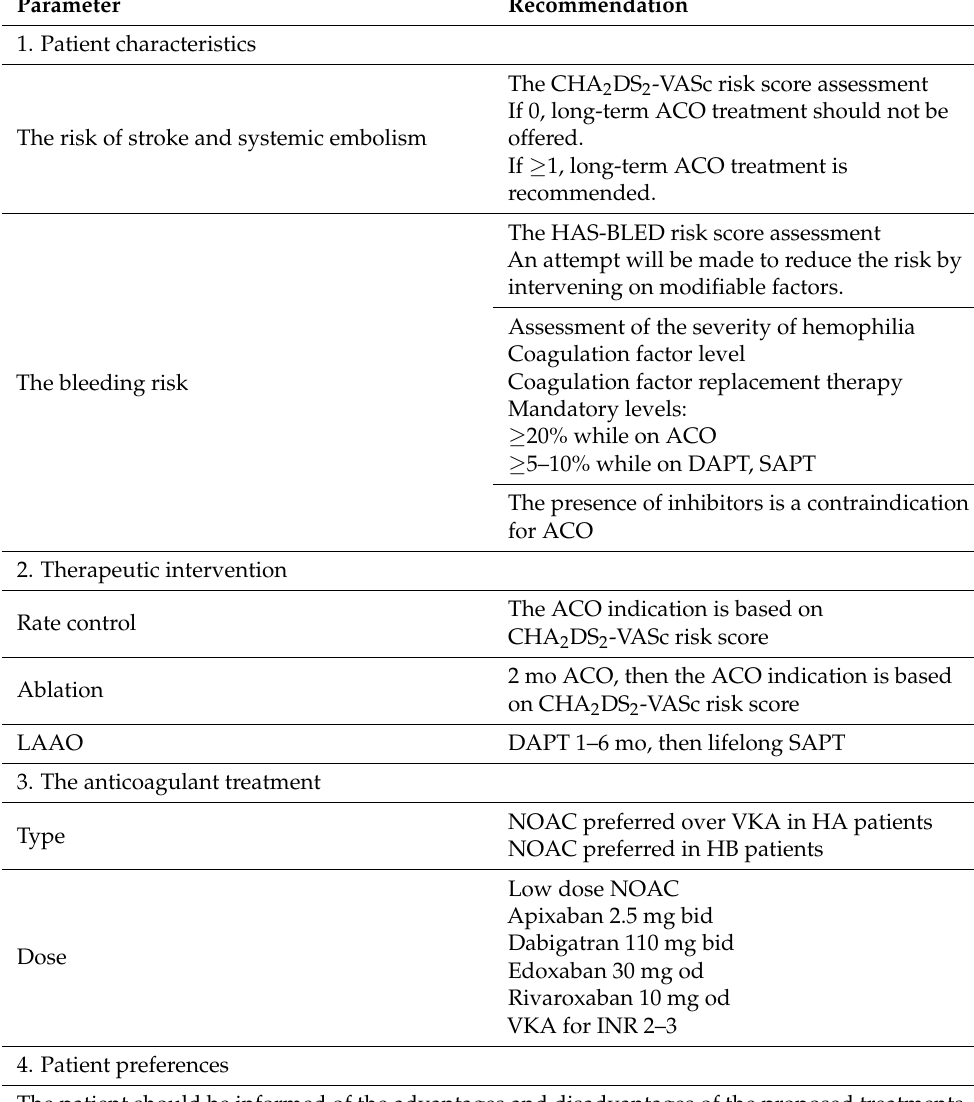
Table 2. Practical guide for long-term antithrombotic